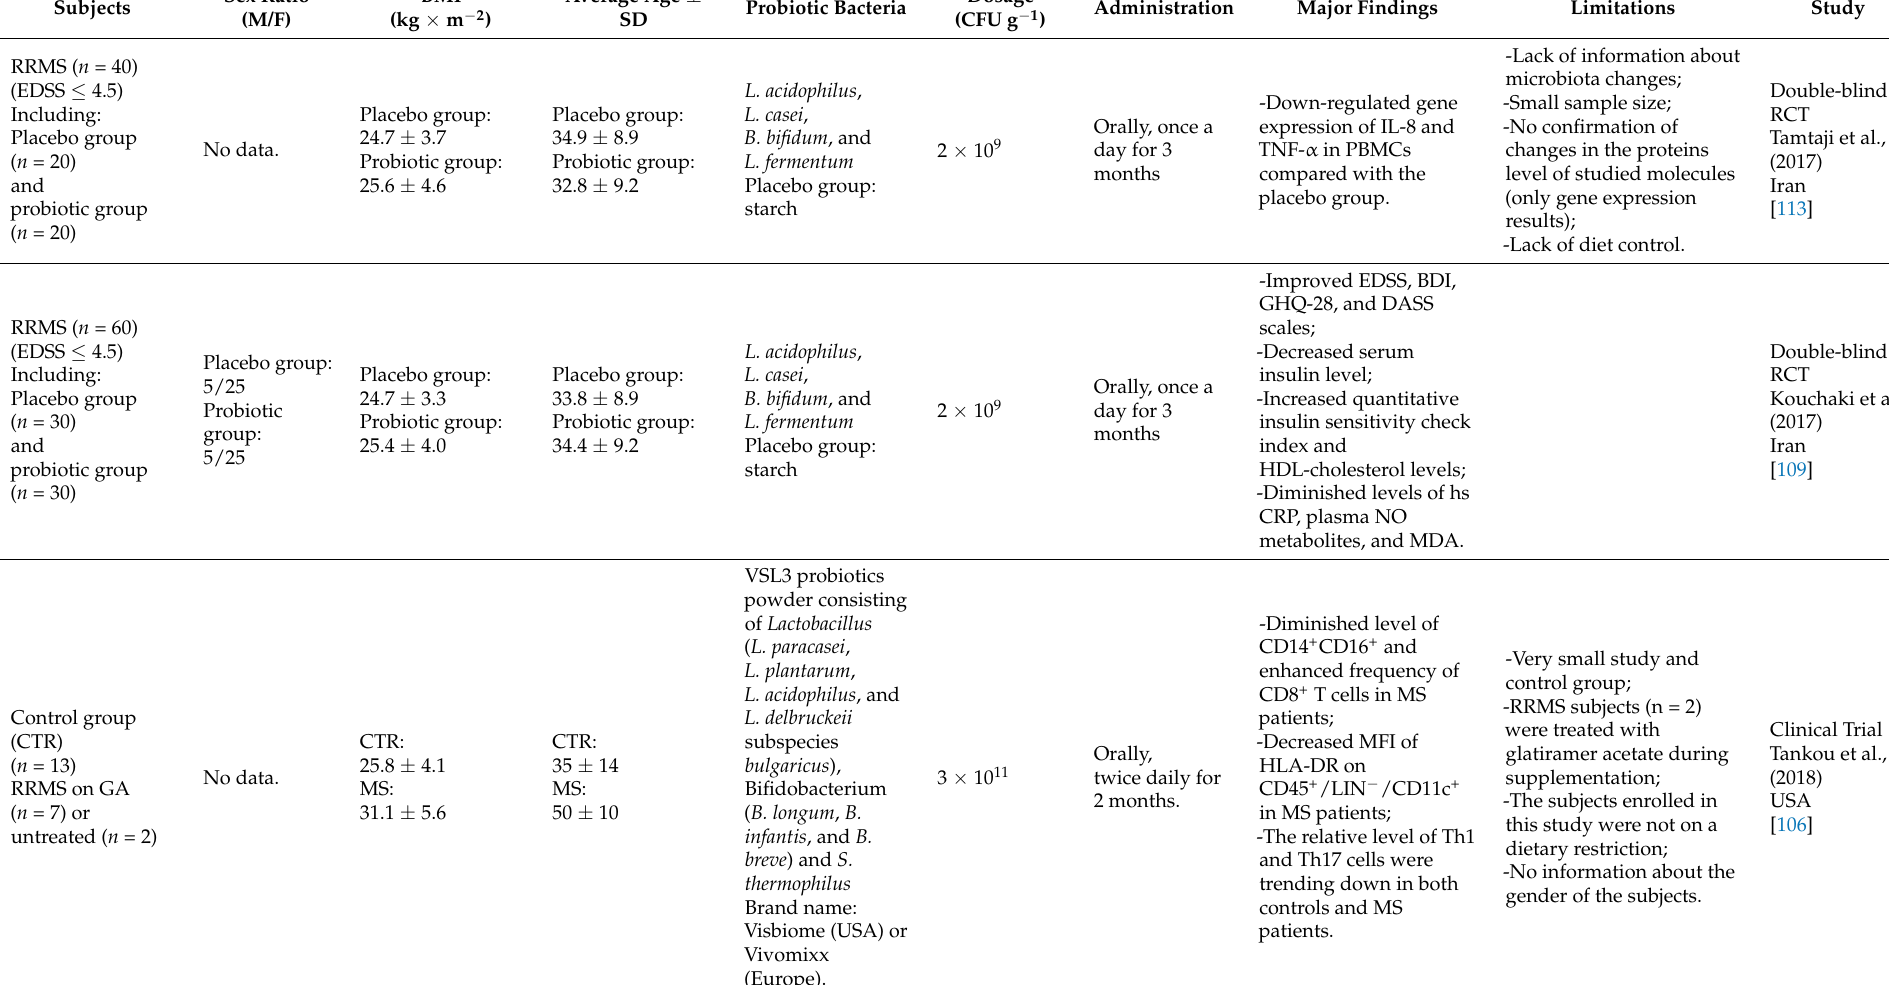
Table 3. Characteristic of the clinical studies concerning probiotic